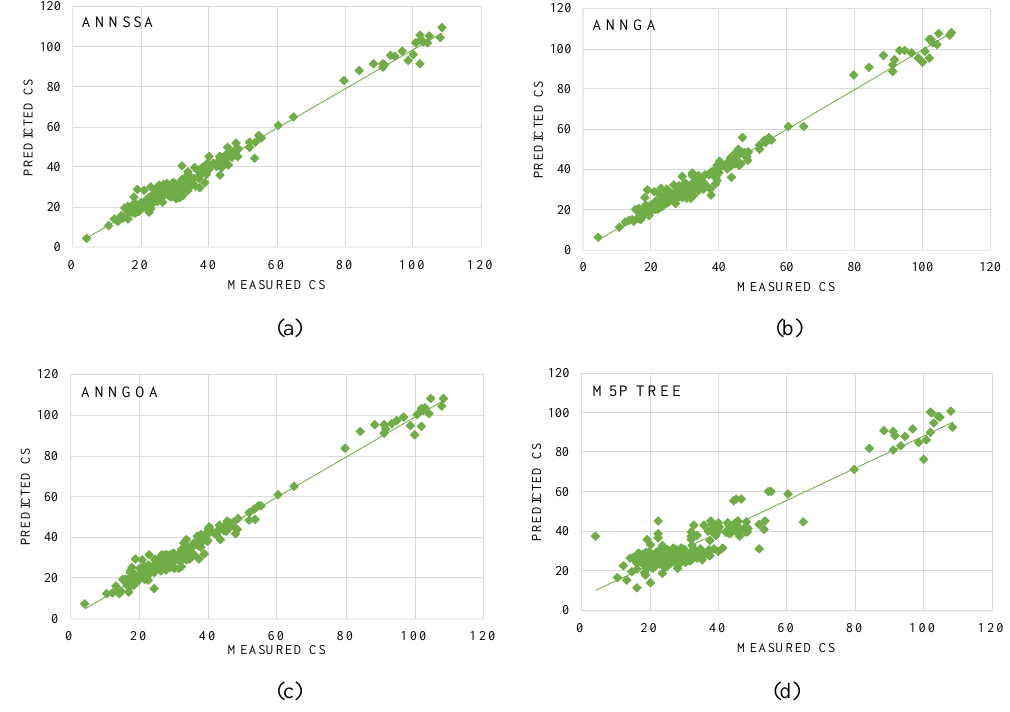
Figure 7. Predicted vs measured compressive strength for ( a ) ANNSSA, ( b ) ANNGA, ( c ) ANNGOA, and ( d ) M5P three.